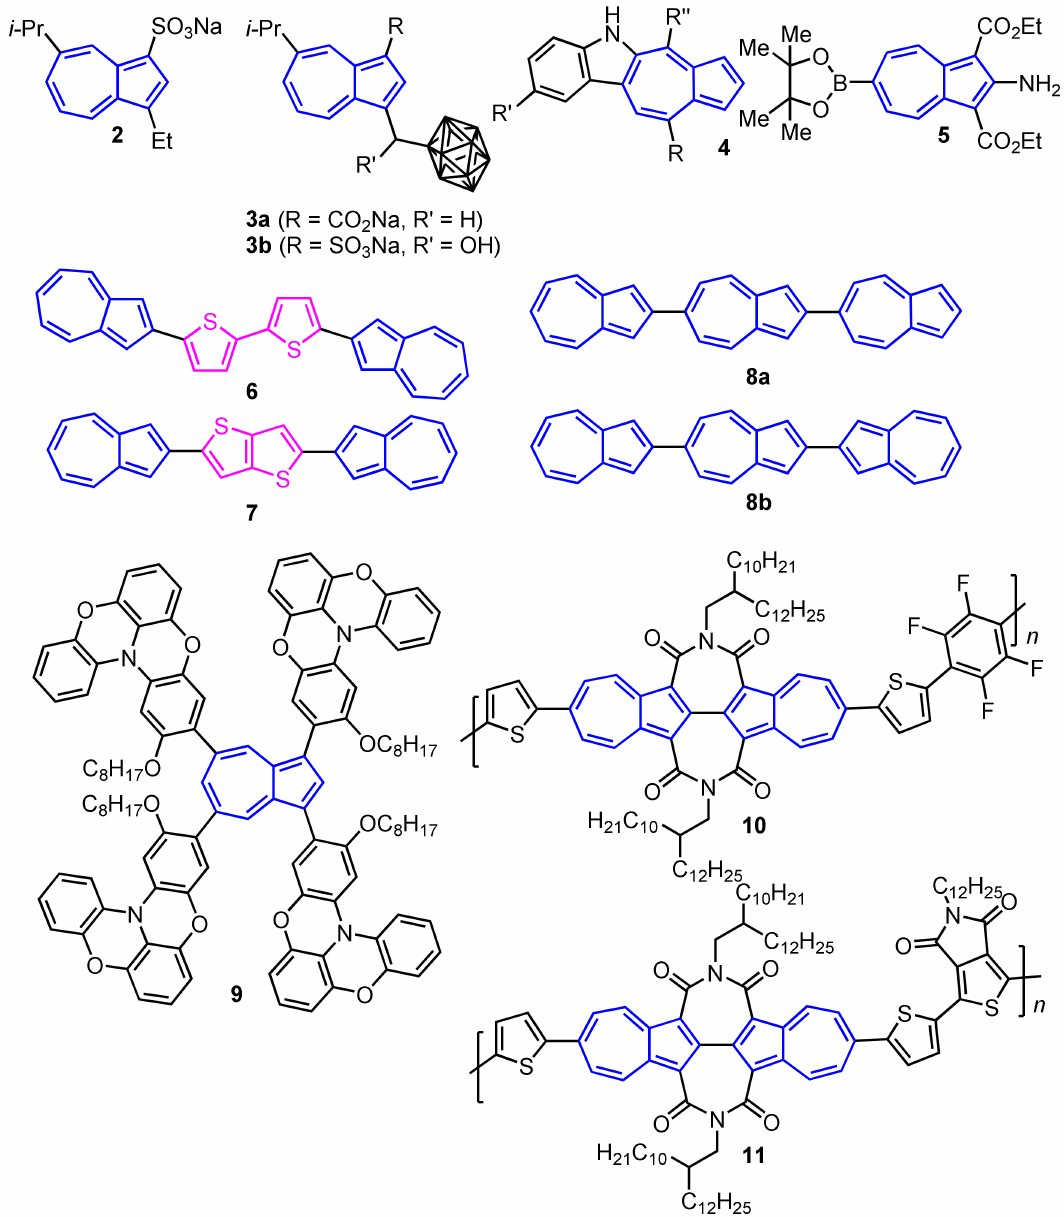
Figure 1. Azulene derivatives promising application to biologically active substances and organic materials.